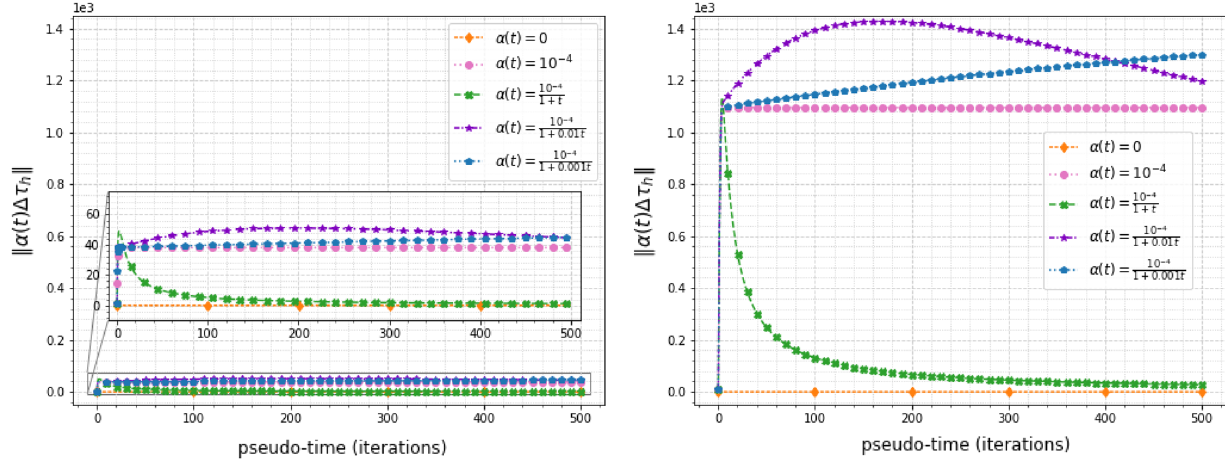
𝛼 ( t )Δ 𝝉 n for different values of 𝜀 in the diffusion coefficient 𝛼 ( t ) = 10 − 4 ‖ ‖